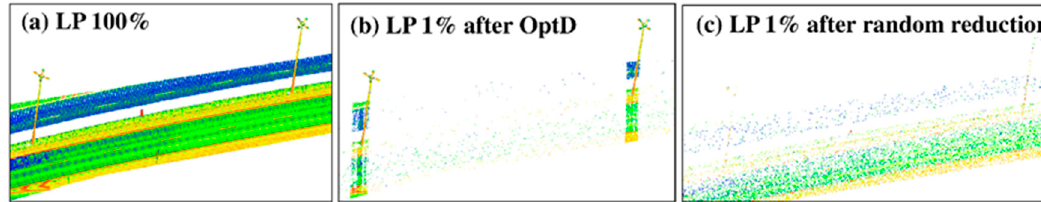
Figure 4. Effect of the data reduction on an area containing LPs: ( a ) original view, ( b ) point cloud after OptD method, ( c ) point cloud after random reduction.